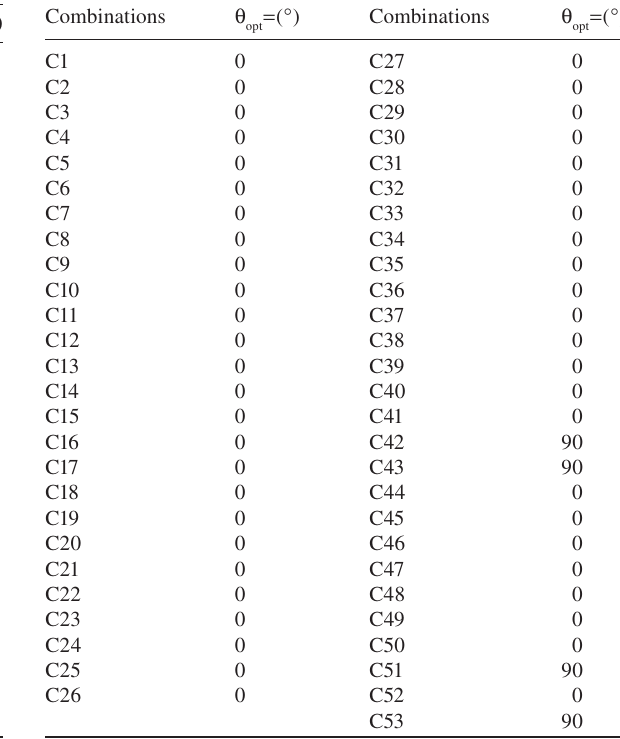
Table 10 Optimum fi ber orientations for laminated plates with intermediate line supports for ( CFCF ) boundary condition.